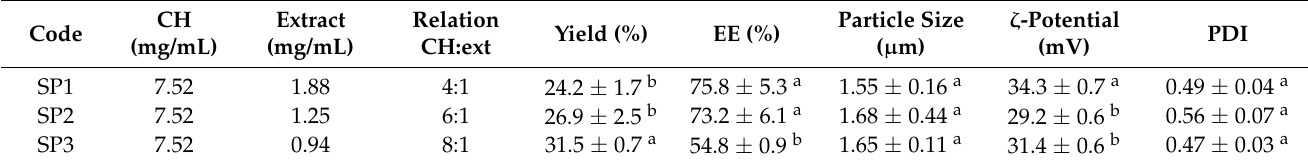
Table 3. Characterization of formulations obtained by spray drying (mean ± SD, n = 3). Relation CH:ext: relation